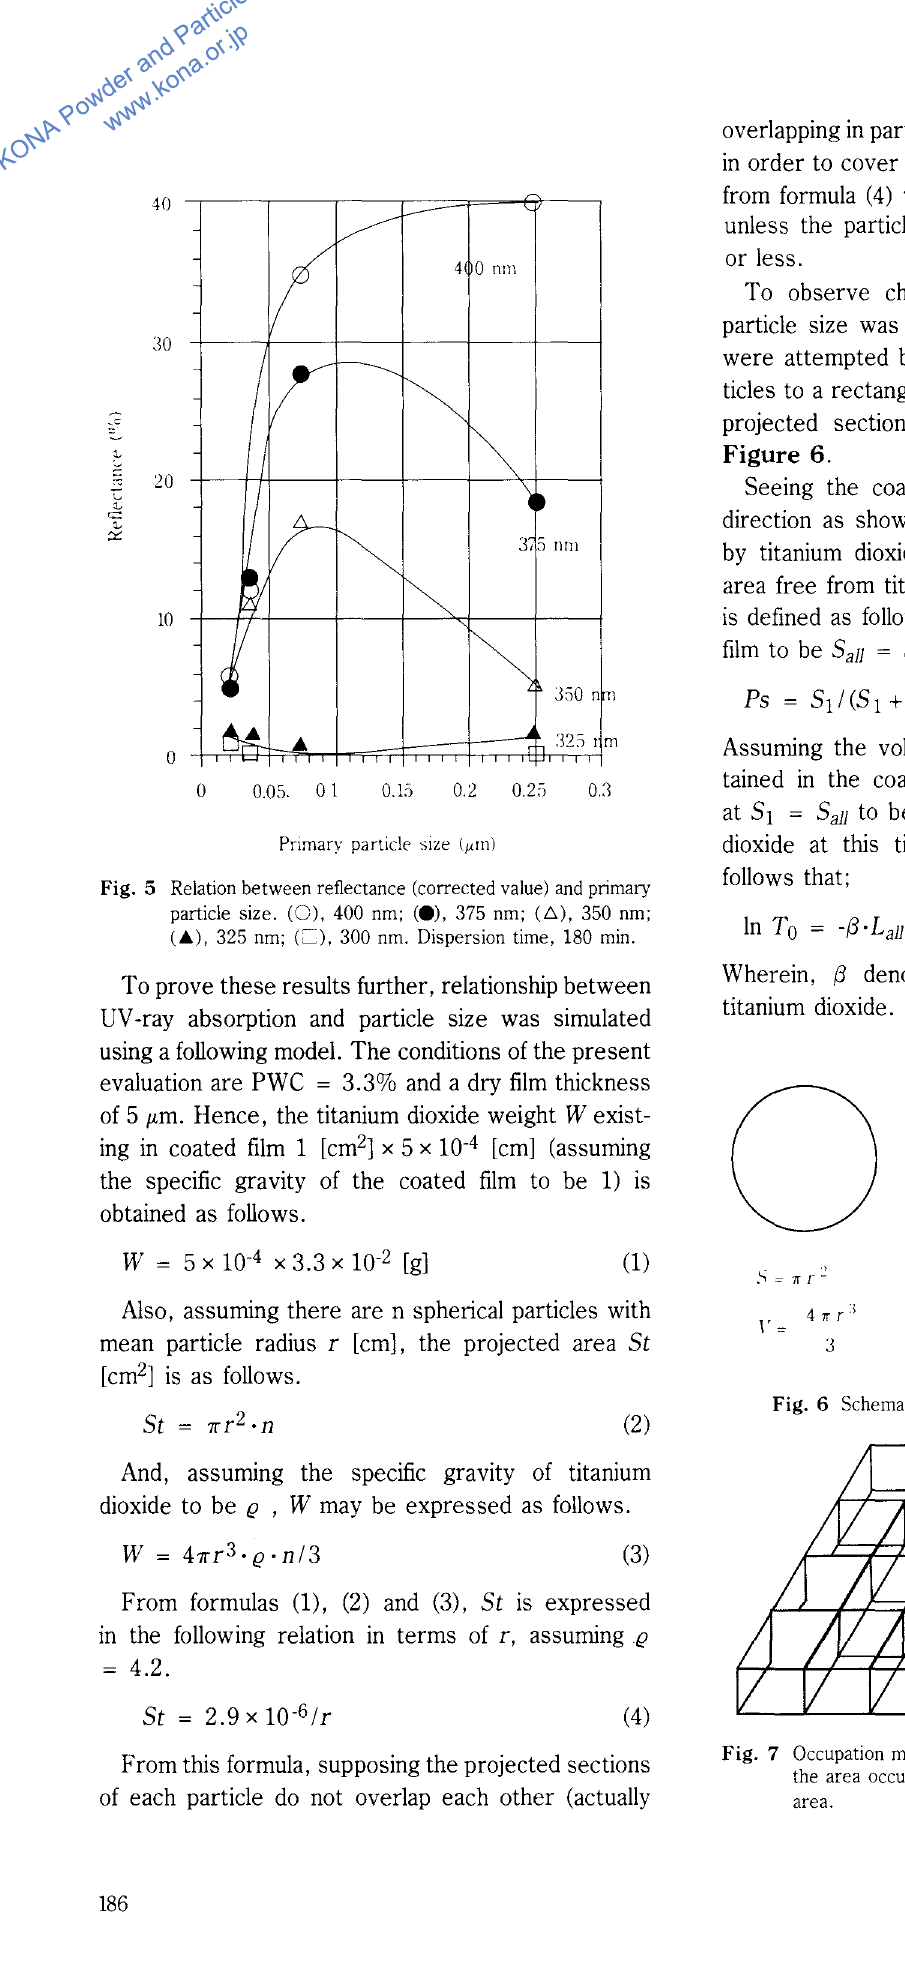
Fig. 6 Schematic model of particle shape conversion